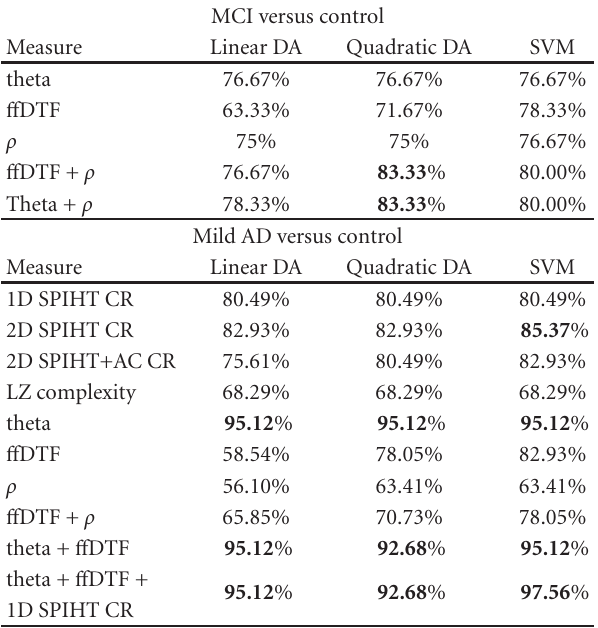
Table 3: Classification rates for discriminant analysis (DA) of the lossless compression ratios, LZ complexity and relative power in theta